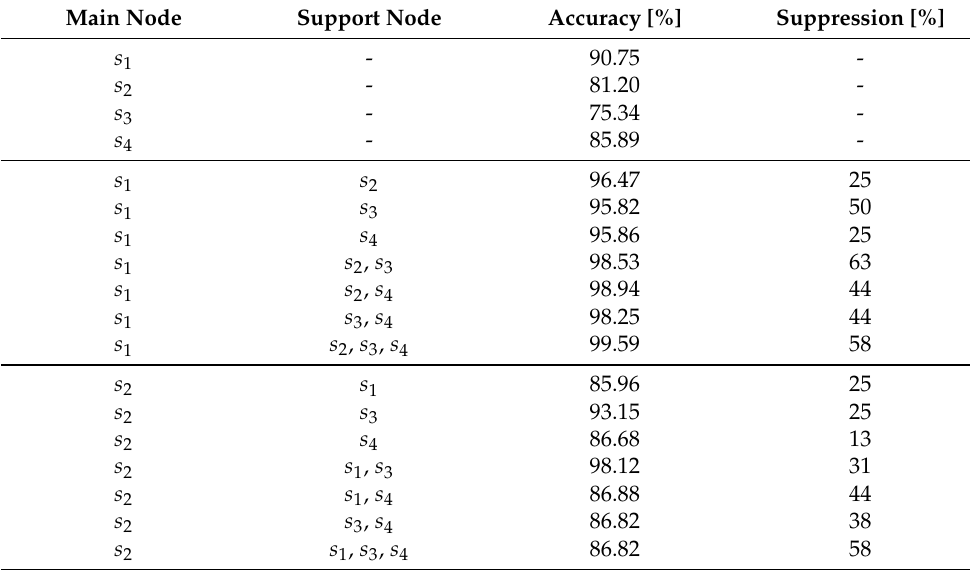
legend: s 1 —waist, s 2 —chest, s 3 —leg, s 4 —arm. Table 2. Verification of selected sensor node